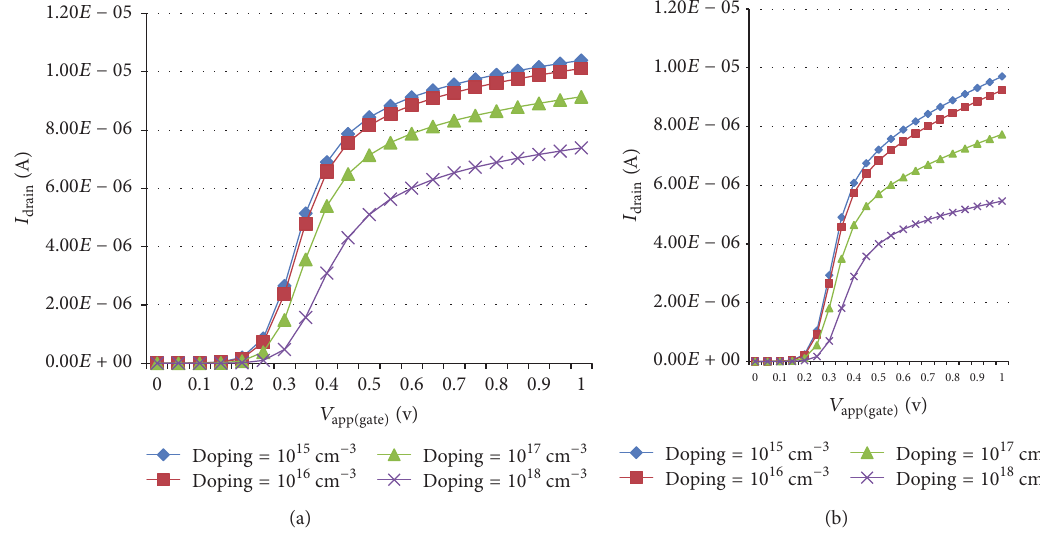
Figure 5: Transfer characteristics of triangular FinFET. (a) For 15 nm fin height. (b) For 40 nm fin height.